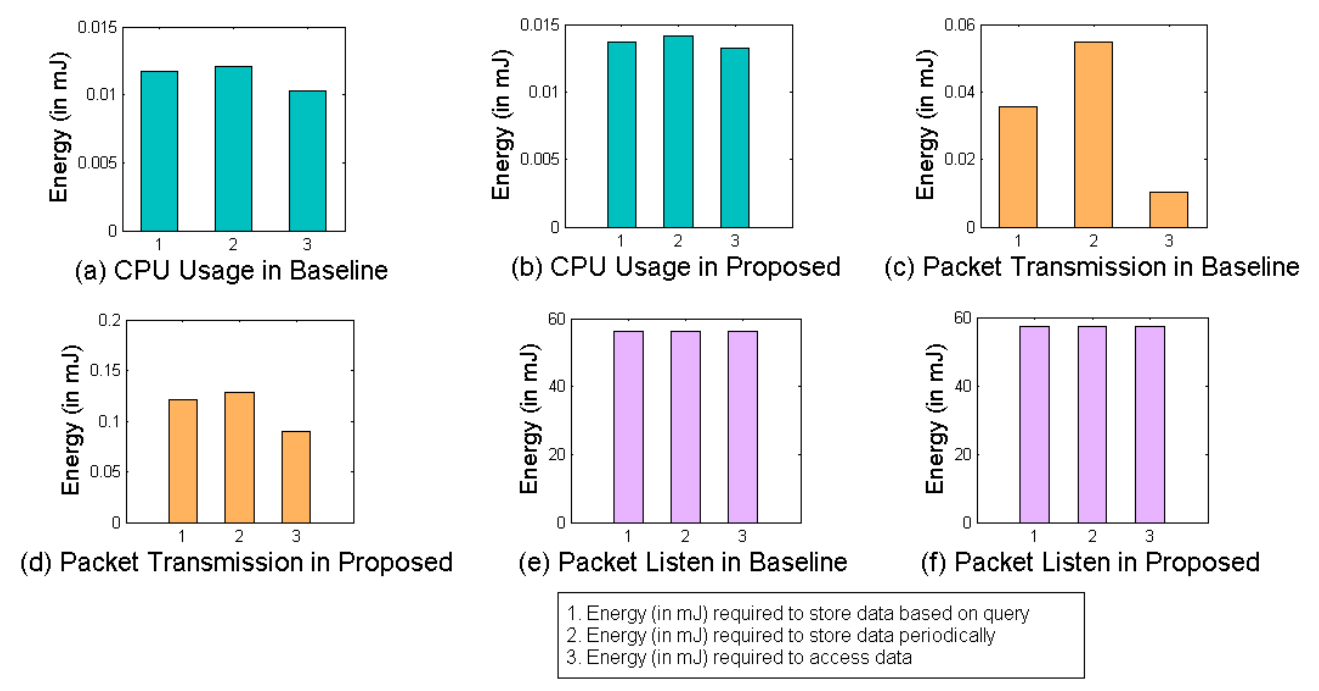
Figure 8. Energy consumption in baseline model and proposed framework at different instances.